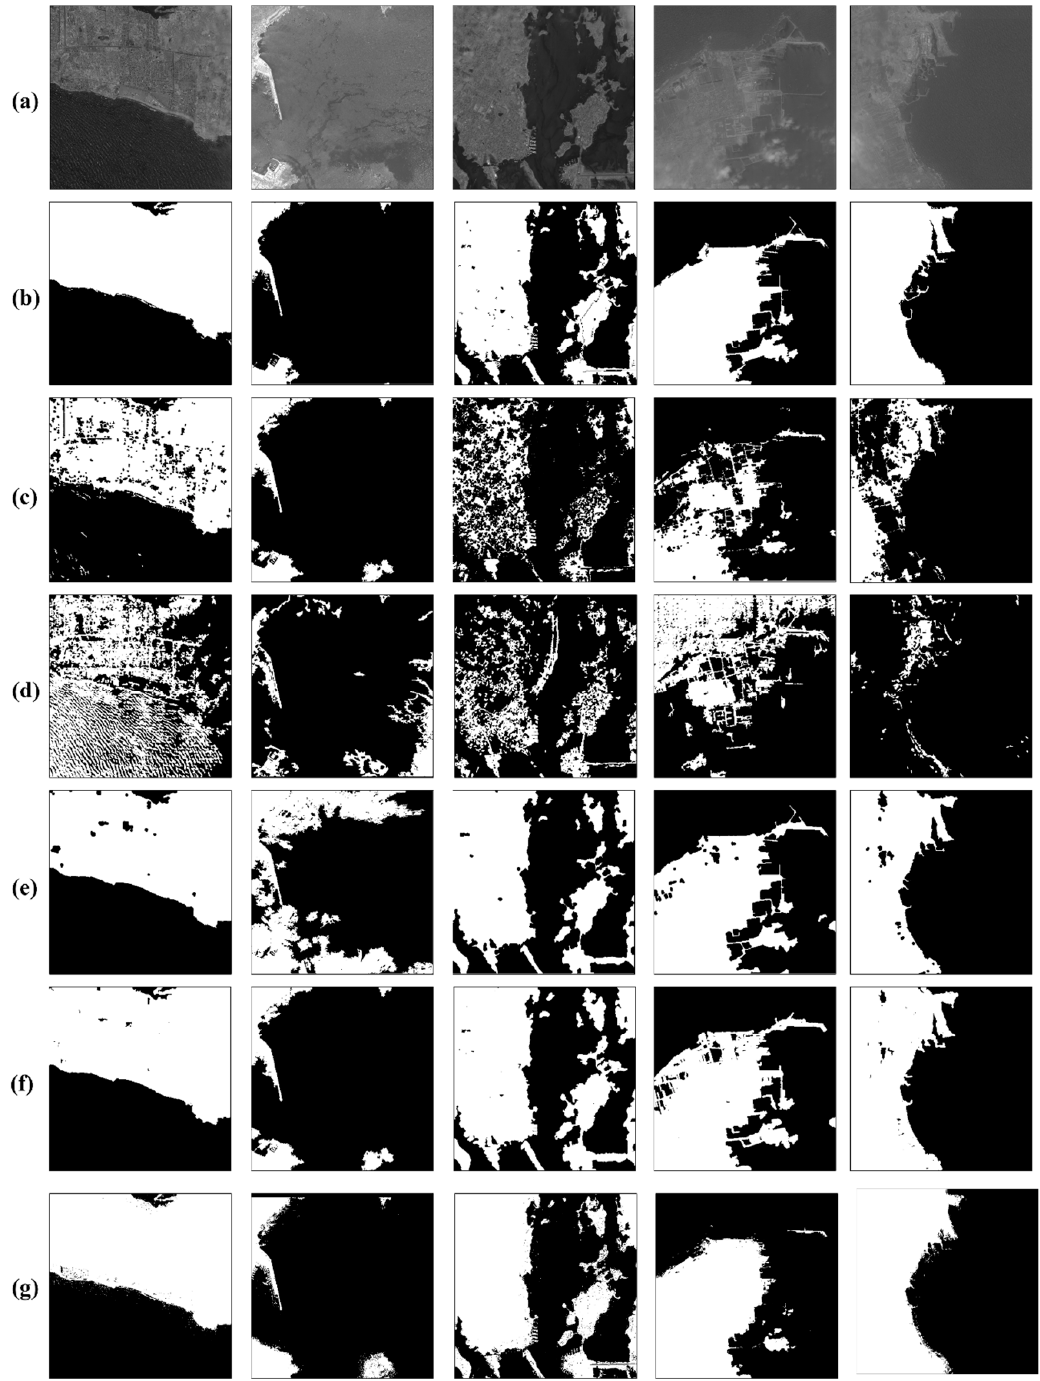
Figure 13. Results of hard images for testing refined water body extraction performance. ( a ) original panchromatic images, ( b ) Proposed method, ( c ) GL [39], ( d ) LBP [37], ( e ) ME [30], ( f ) HSS [32], ( g ) SeNet [23].